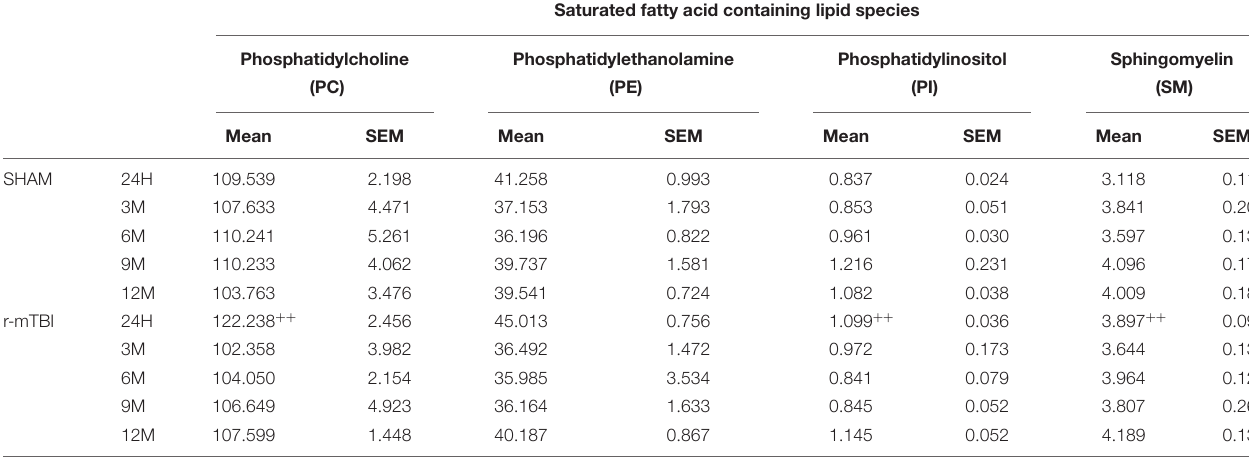
TABLE 5 | Saturated fatty acid containing phospholipid species in the cortex of repetitive mTBI hTau mice.